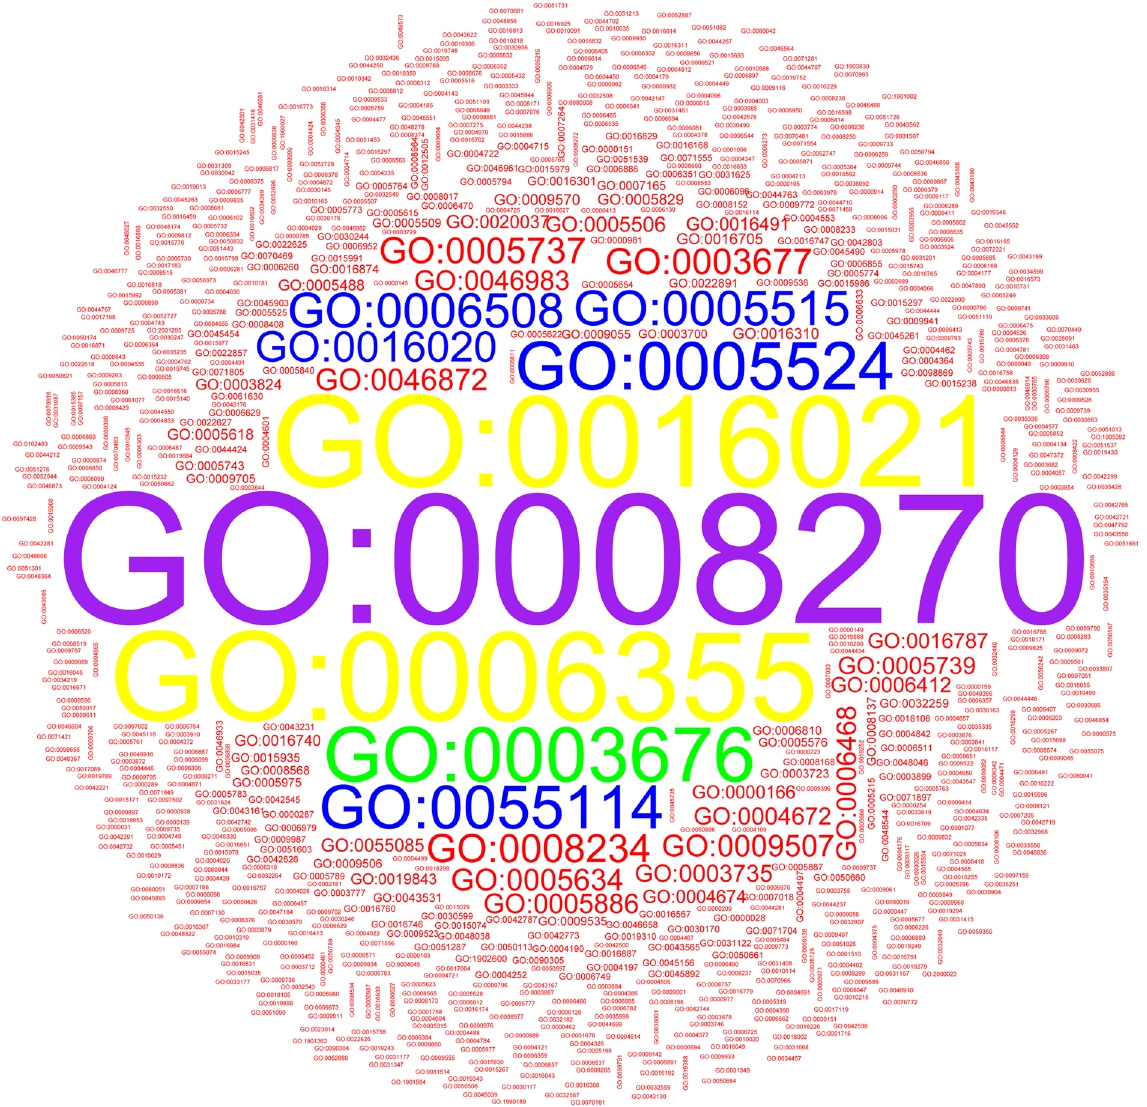
Figure 2. Identification of GO items in tissue-specific genes. The detailed GO annotation listed in Table